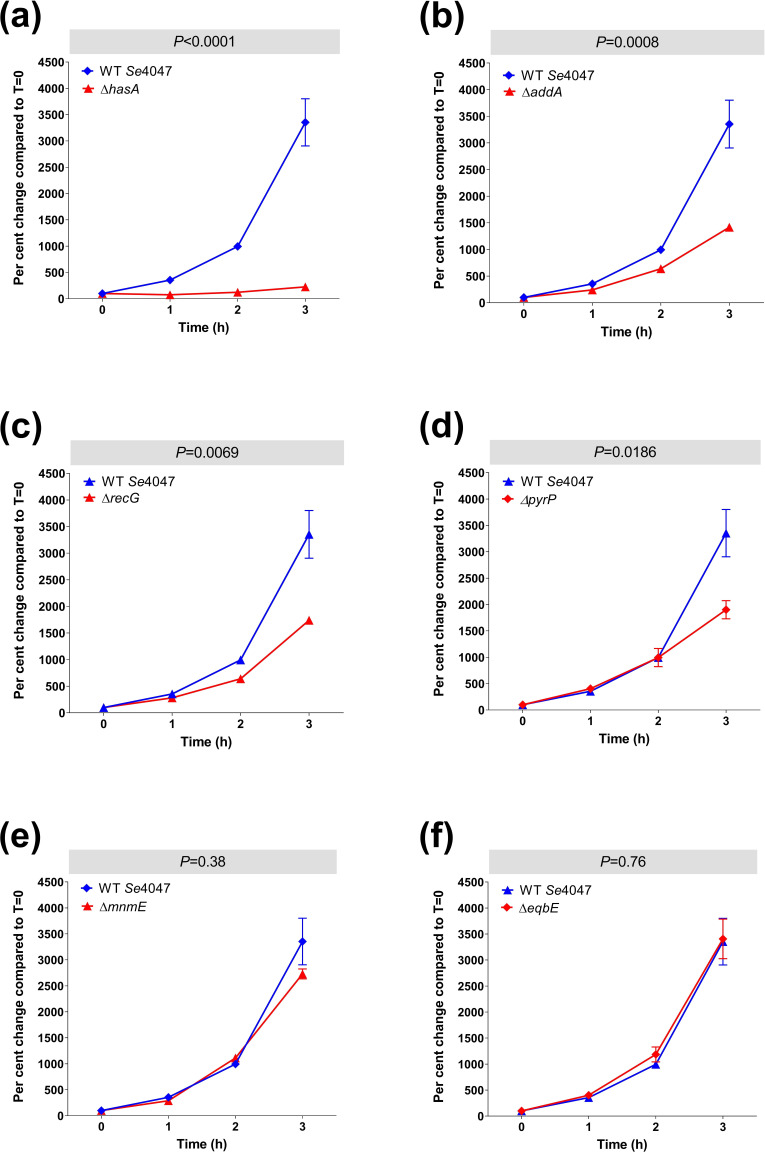
Validation of the
S. equi
 subsp.
equi
 TraDIS screen in whole equine blood. Strains with deletion mutations of whole equine blood fitness genes, as identified by TraDIS, were incubated in blood for 3 h and their survival measured each hour. (a) ΔhasA, (b) ΔaddA, (c) ΔrecG, (d) ΔpyrP, (e) ΔmnmE and (f) ΔeqbE deletion mutation strains compared to the wild-type parental strain, Se4047. Error bars indicate the se. The significance of changes in doubling time using a two-sided Student’s t-test are indicated.